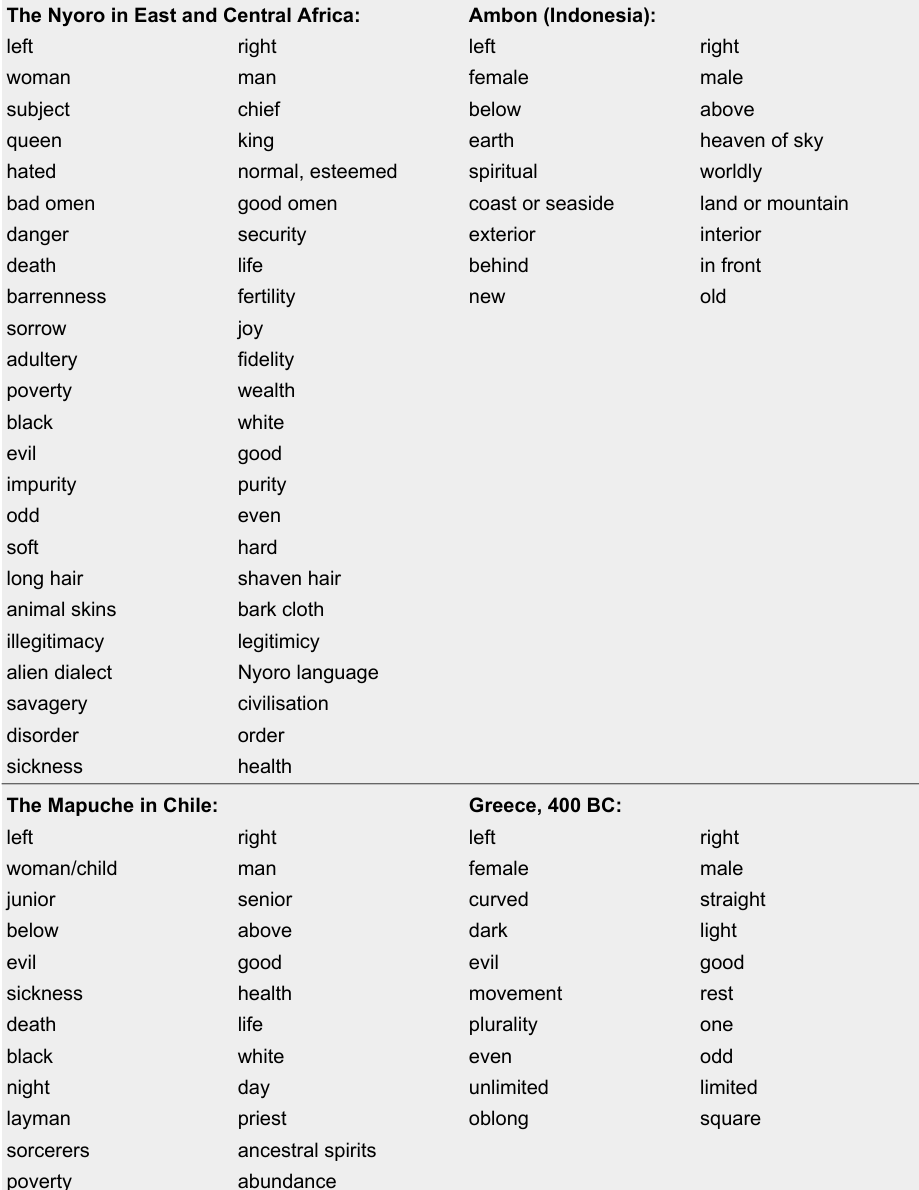
Left and Right in Different Cultures